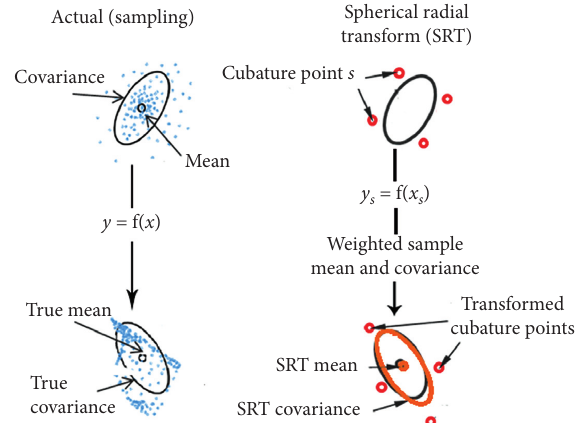
Figure 4: Illustration of the spherical-radical transformation for mean and covariance